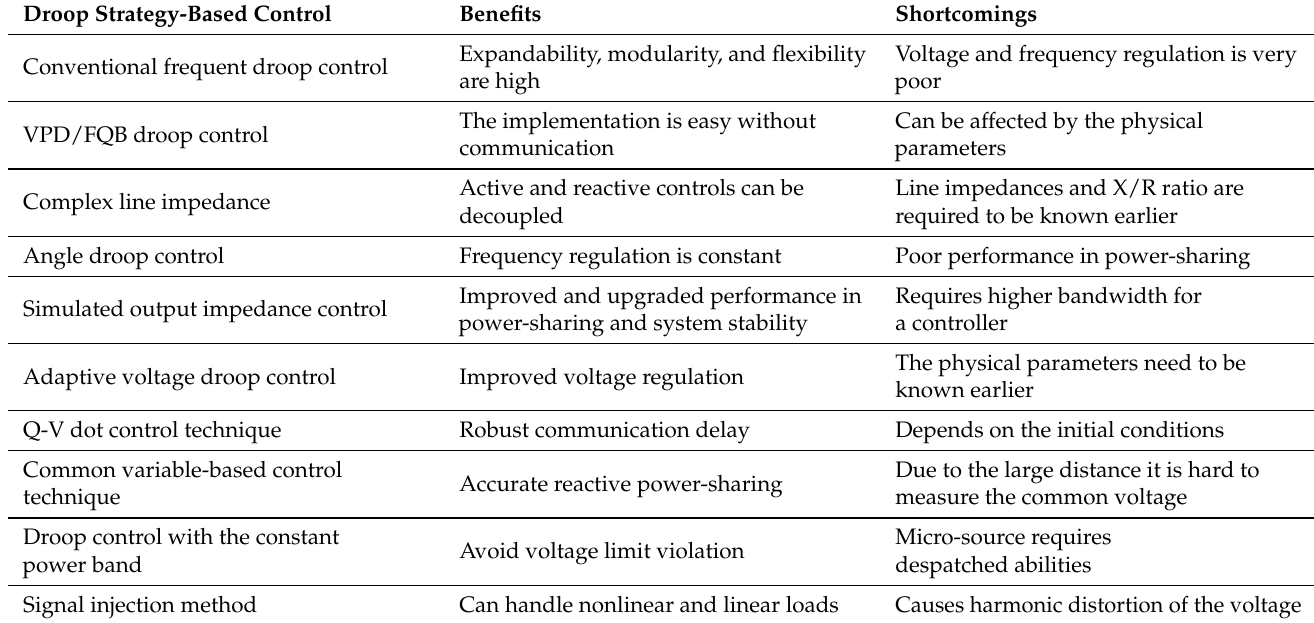
Table 9. Prospective benefits and shortcomings of droop-strategy-based control